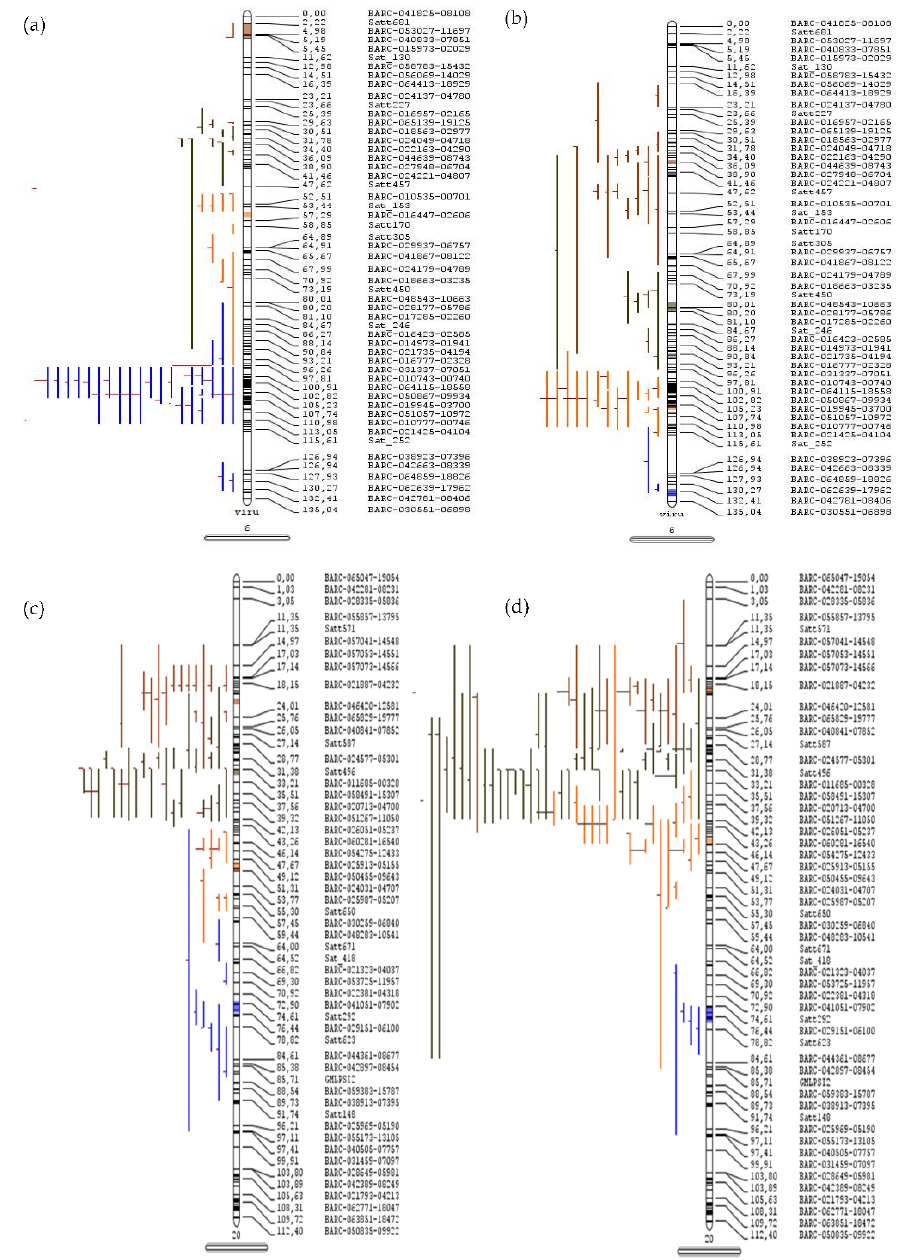
Figure 1. Meta-quantitative trait loci for seed oil and protein content in soybean. The QTLs projected on chromosome 6 for ( a ) seed oil and ( b ) protein content and on chromosome 20 for ( c ) seed oil and ( d ) protein content. The vertical bars with rounded ends represent the chromosome, the colored lines on left side represent the QTLs, and the right sides of the bars indicate the position (cm) and name of marker.